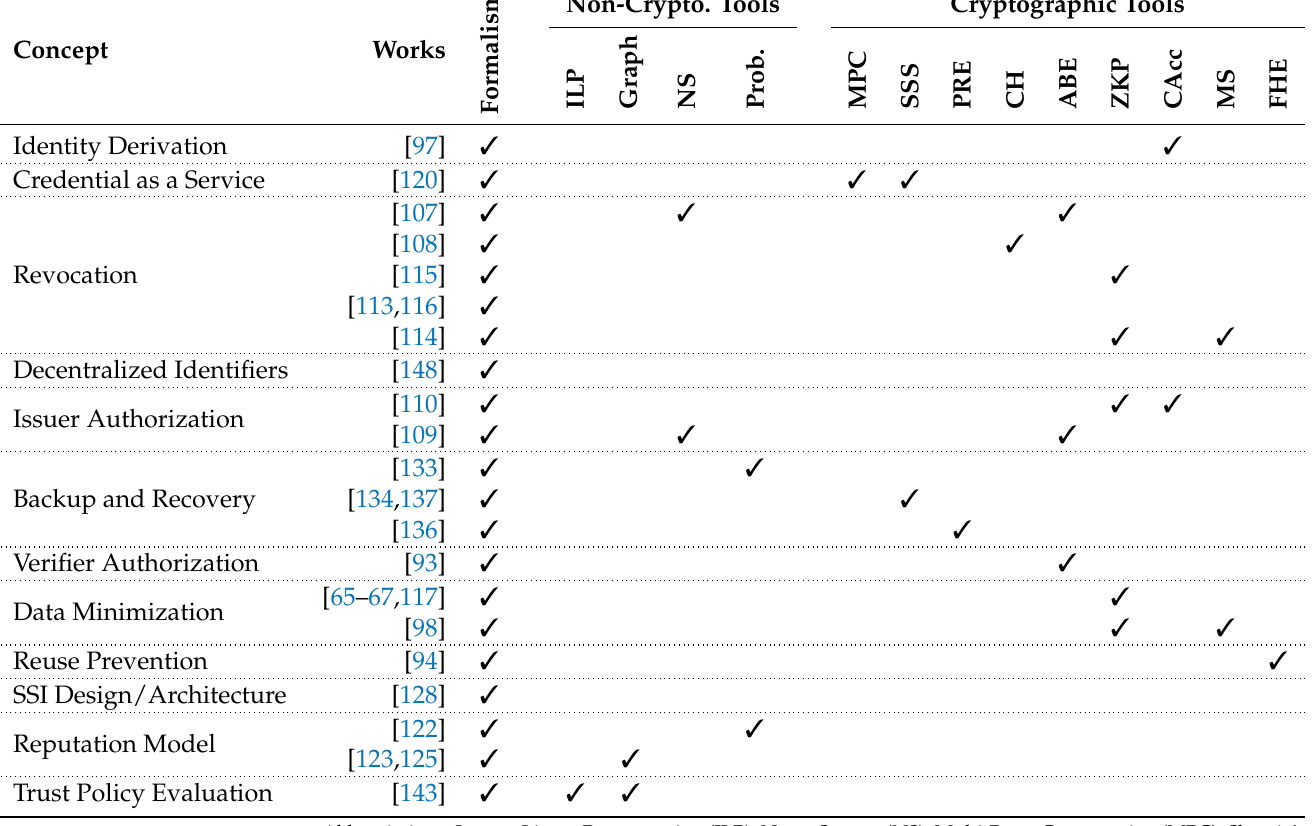
cryptographic and non-cryptographic